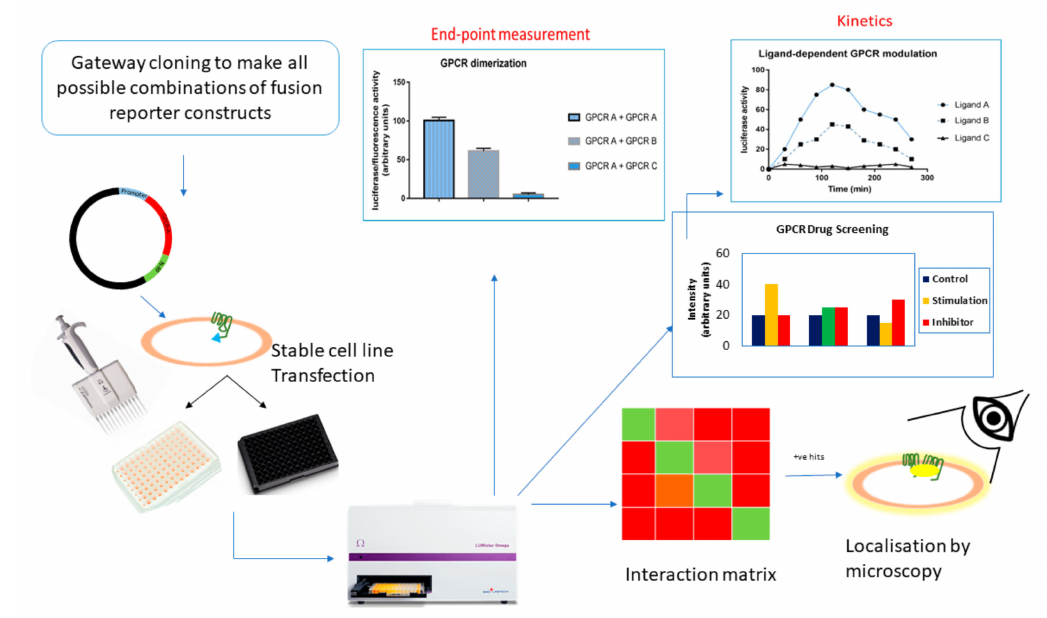
Figure 7. High-throughput